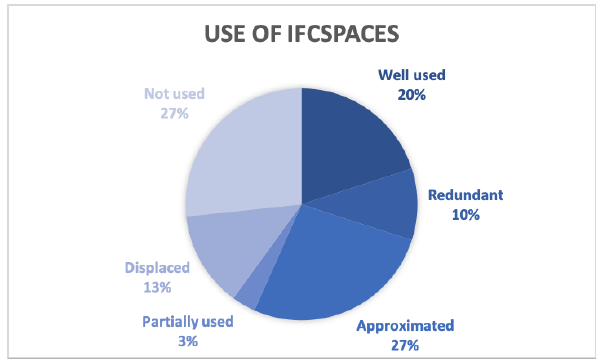
Figure 7. Distribution of models according to the quality of IfcSpace